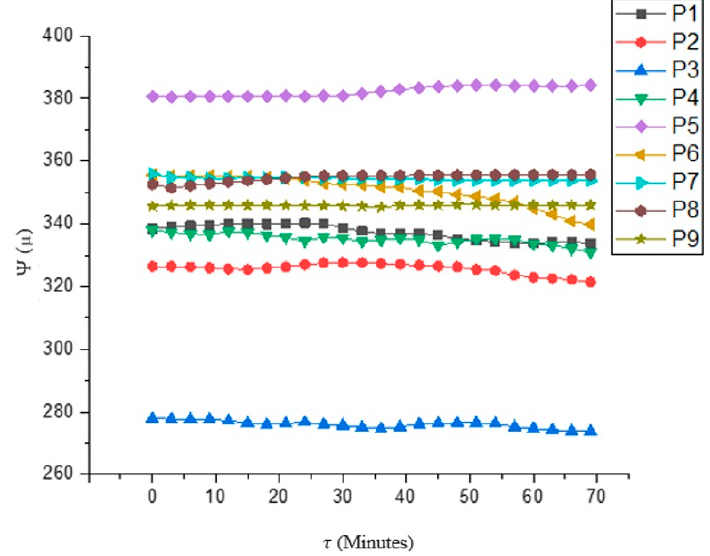
Figure 7. Characterization of infrared LED power with respect to time.